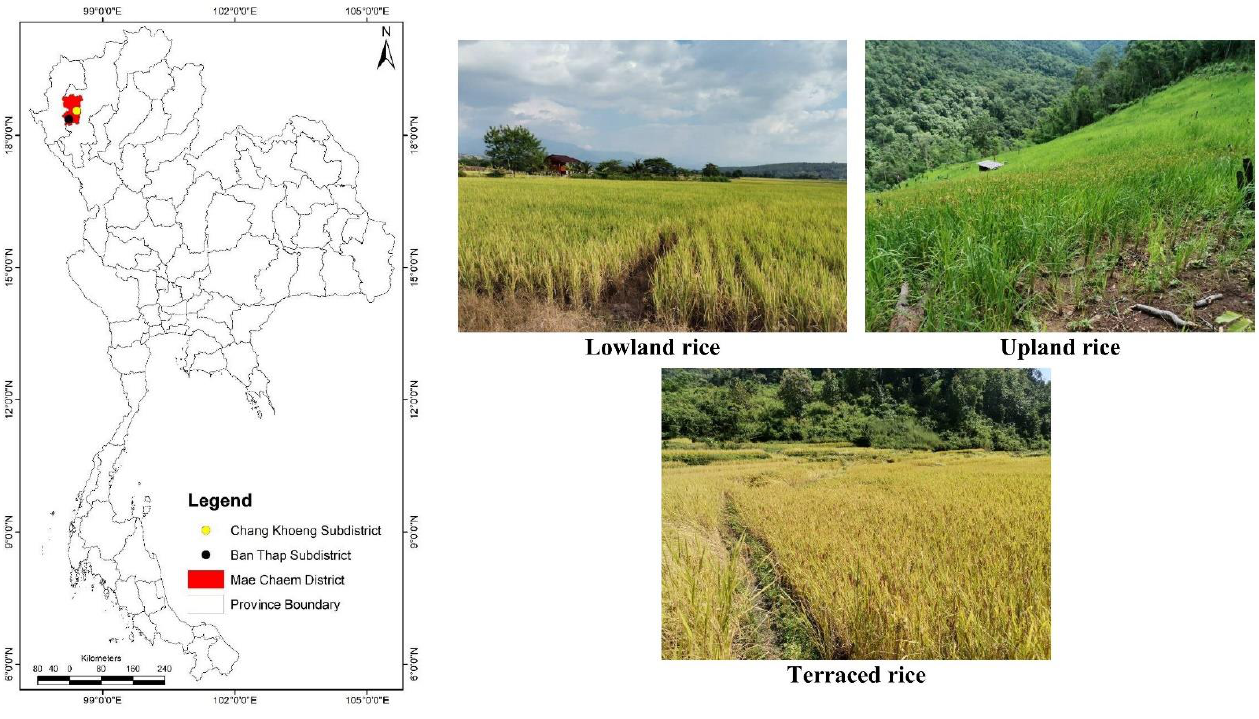
Figure 1 . Study area . Figure 1. Study area.